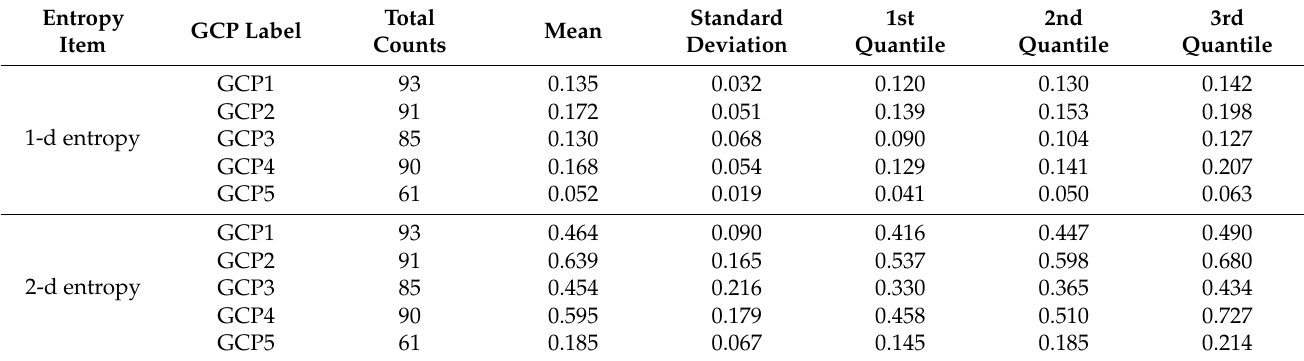
Table 2. The statistical result of the entropy values of the edge distribution for five GCPs.